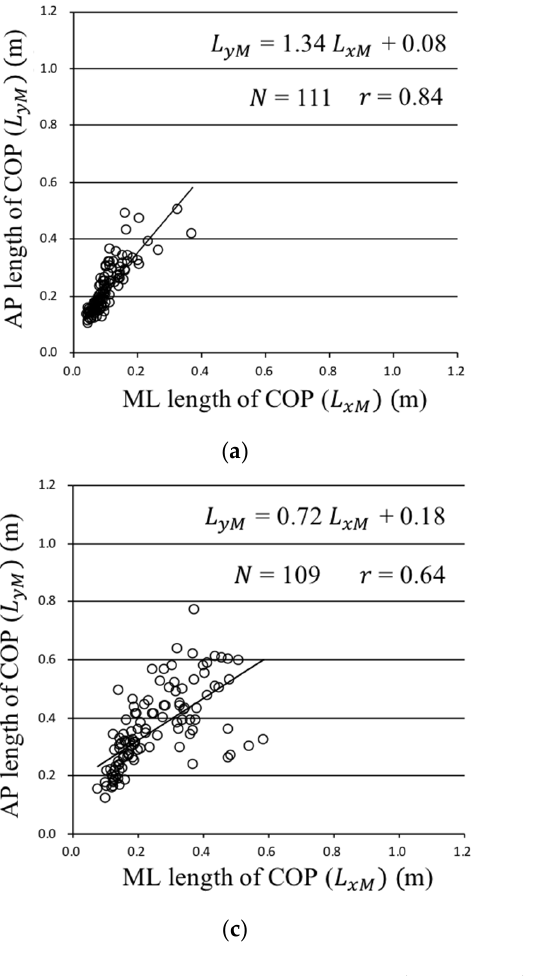
Figure 10. Scatter diagram and regression lines of the mediolateral (ML) and anteroposterior (AP) lengths of the ratio shown in Figure 9h: ( a ) Pattern 1; ( b ) Pattern 2 (wave direction: 180°); ( c ) Pattern 3 (wave direction: 135°); ( d ) Pattern 4 (wave direction: 90°).